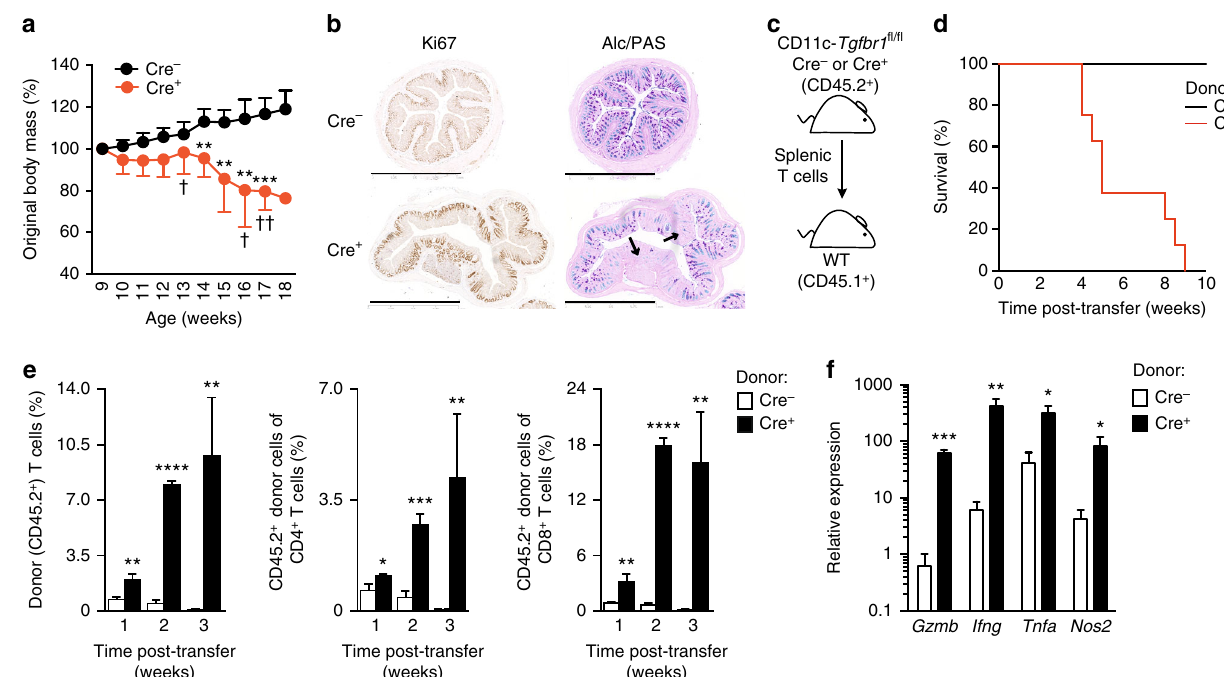
Fig. 1 T-cell-dependent in fl ammatory disease in CD11c-Cre. Tgfbr1 fl / fl mice. a Body weights of CD11c - Cre. Tgfbr1 fl / fl (Cre + ) mice and Tgfbr1 fl / fl (Cre − ) mice littermate controls presented as a percentage of original bodyweight at 9 weeks of age. The results are the means ± 1 SD of fi ve (Cre + ) or six (Cre − ) mice per group and are representative of two experiments (** p < 0.01 and *** p < 0.001 — Student ’ s t -test followed by Holm – Sidak correction). ( † indicates the loss of animal from group). b Representative colonic pathology as assessed by epithelial cell turnover (Ki67 staining — left panels ) and goblet cell density (PAS staining — right panels ) in Cre − ( upper panels ) and Cre + mice ( lower panels ). Arrows indicate loss of goblet cells. Scale bar , 1 mm. c Experimental scheme for the transfer of splenic T cells from Cre − or Cre + mice into congenic WT recipients. d Survival of WT recipients given T cells from Cre − ro Cre + mice. Data are pooled from two experiments with a total of seven (Cre − ) or eight (Cre + ) mice per group. e Frequency of CD45.2 + donor T cells among total blood T cells ( left ) and the frequency of donor cells within the CD4 + and CD8 + T-cell compartments ( centre and right ) at 1, 2 and 3 weeks post transfer in the mice from c , d above. Data are from one of two independent experiments each with 3 (Cre + ) or 4 (Cre − ) mice per group. f Expression of mRNA transcripts for Gzmb , Ifng , Tnfa and Nos2 in the stomach of recipients of splenic T cells from Cre − or Cre + mice in d above. In e , f , bars represent the mean + SD of three mice per group and mRNA expression is relative to expression of Gapdh . * p < 0.05, ** p < 0.01, *** p < 0.001 and **** p < 0.0005 determined